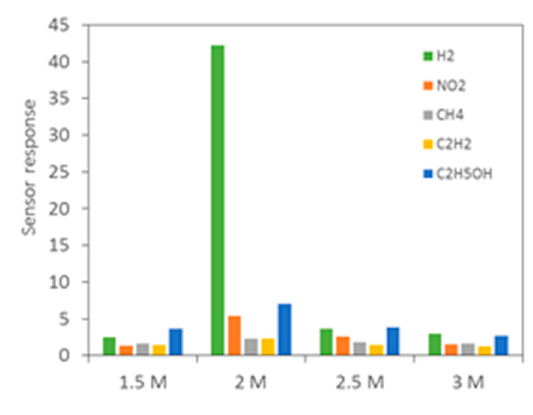
Figure 6. Selectivity histogram of 2D WO 3 nanostructures prepared by anodization with different HNO 3 concentrations at 1 vol